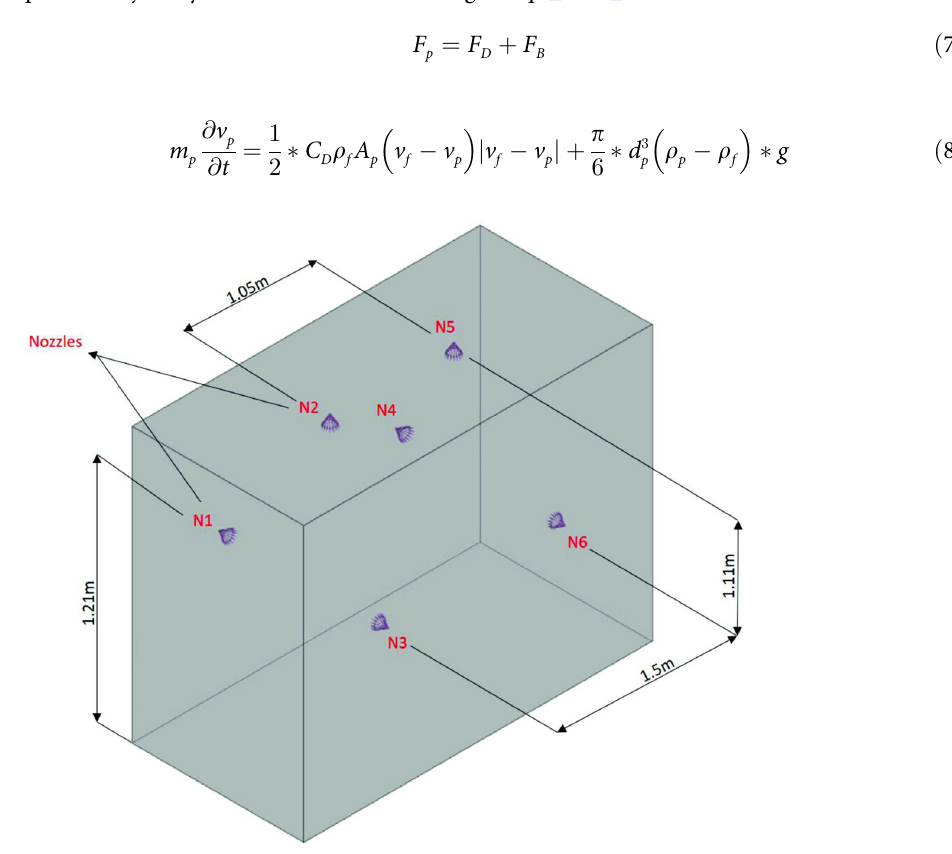
Fig 6. Computational domain of the disinfection